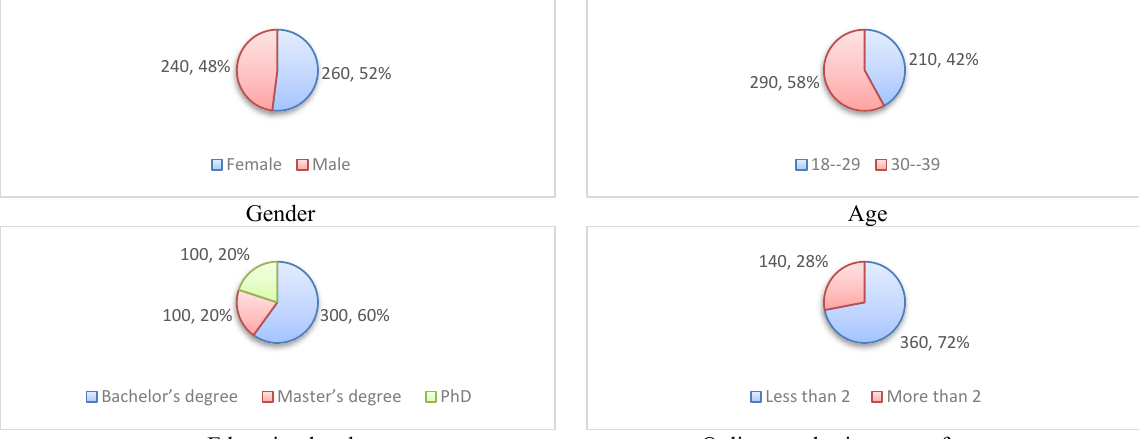
Fig. 2. Personal characteristics of the